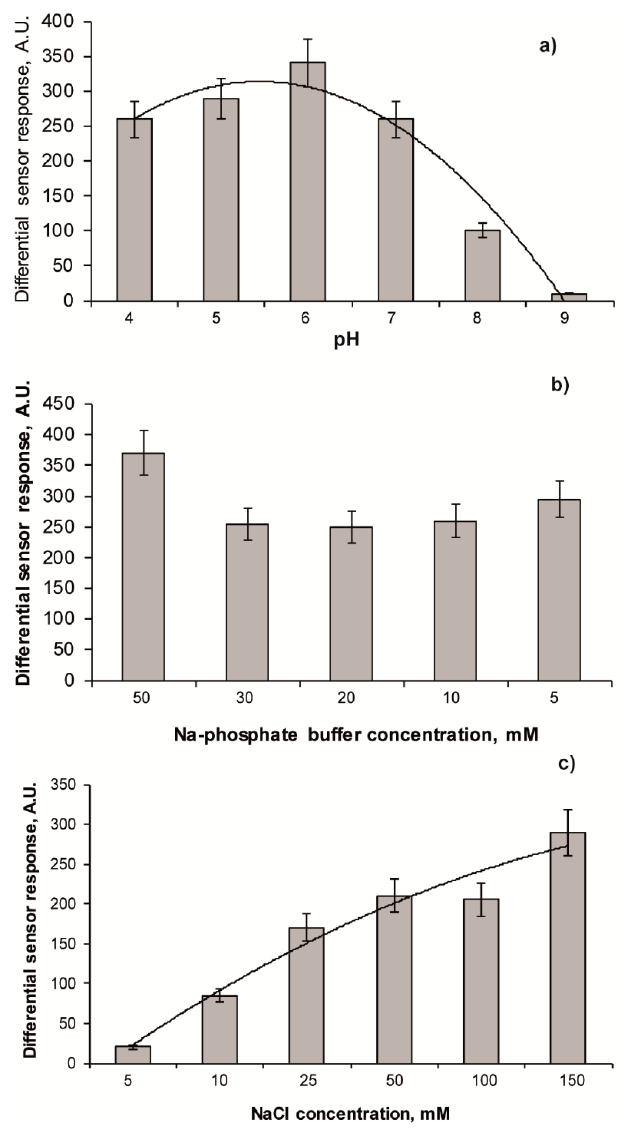
Figure 5. ( a ) Influence of pH of the analysed sample on the values of the sensor signal (aqueous working solution contained 25 µ g mL − 1 zearalenone and 10% acetonitrile). ( b ) Influence of bu ff er capacity on the values of the sensor signal (5–50 mM Na-phosphate bu ff er solutions, pH 6.0, containing 25 µ g mL − 1 zearalenone and 10% acetonitrile were used as working solutions). ( c ) Influence of ionic strength on the values of the sensor signal (5–150 mM NaCl were added to the working solution: 20 mM Na-phosphate bu ff er, pH 6.0, containing 25 µ g mL − 1 zearalenone and 10% acetonitrile). Di ff erential sensor response is a residual between sensor signals obtained by fluorescent sensors based on MIP and corresponding reference polymeric